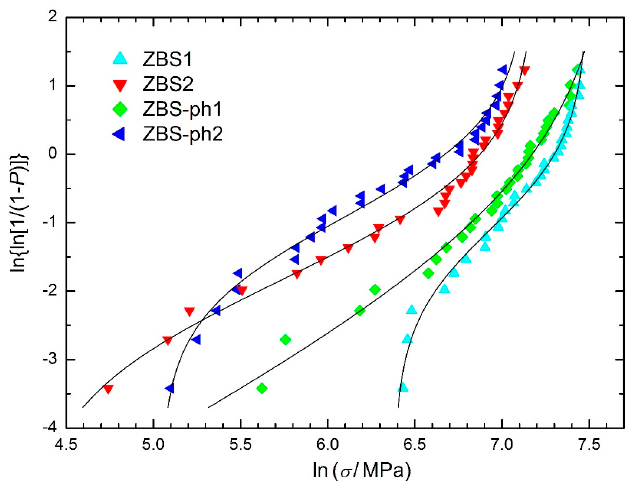
Figure 8. Weibull plots of the tensile strength of coated SiC fibers with given variants of ZrB 2 -SiC coating [5]. Regression function (W4) was successfully applied except for the ZBS-ph1 coating with σ = 0 MPa.